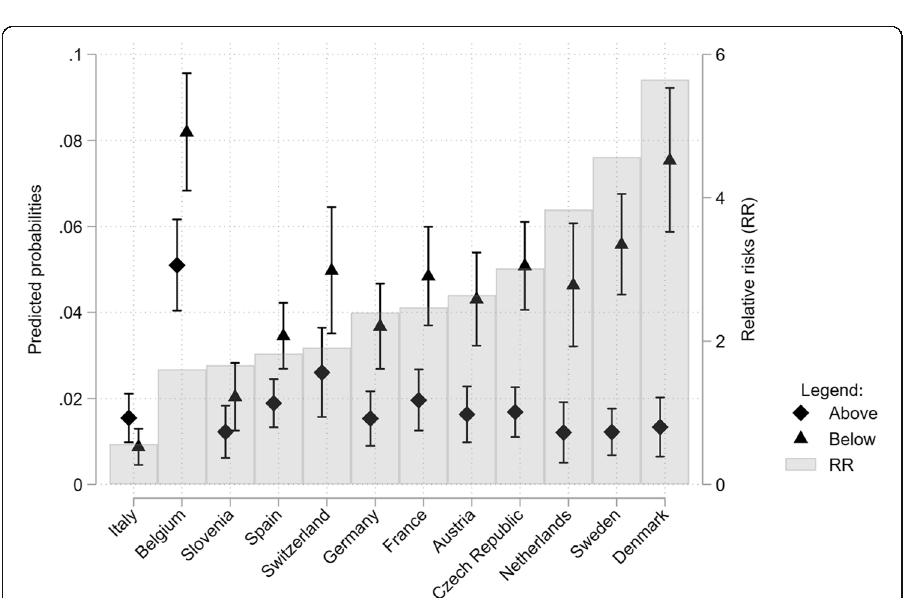
Fig. 7 Predicted probabilities (left axis) and 95% confidence intervals for individuals below the median income (triangles) and above-median equalized income (diamonds) and associate relative risks (RR; bars; right axis) of being in a nursing home by country controlling for respondent ’ s